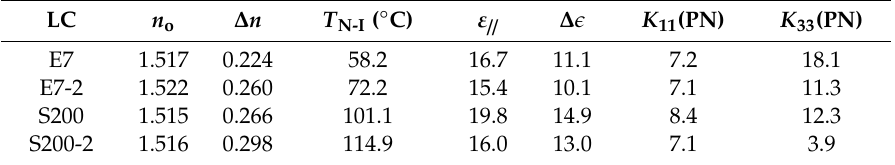
Table 1. Physical properties of nematic liquid crystals (NLCs) E7, E7-2, and S200 and S200-2. LC n o ∆ n T N-I ( ◦ C) ε // ∆